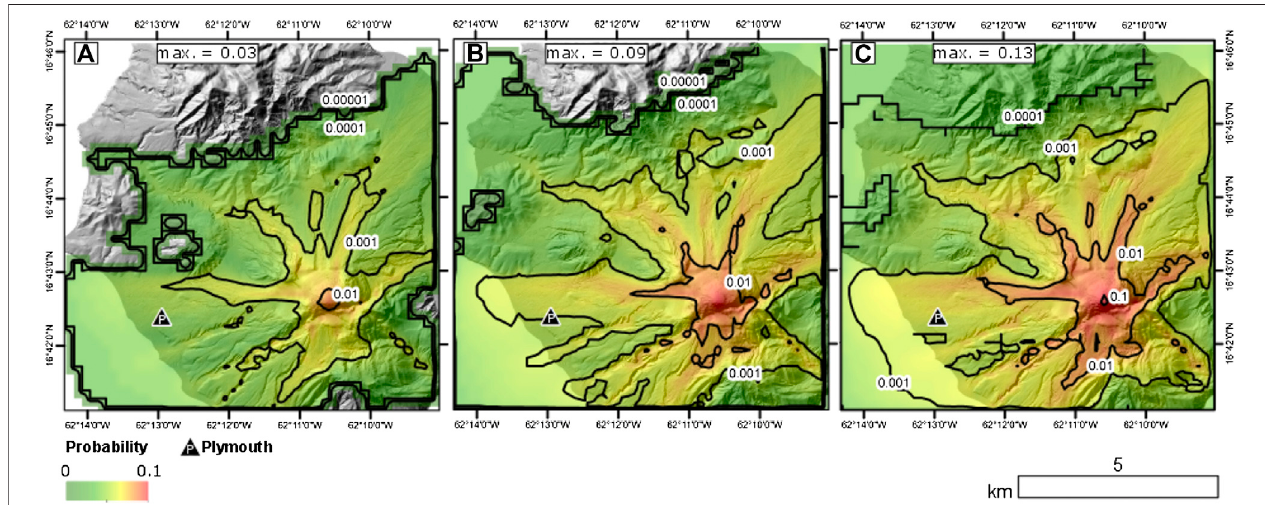
FIGURE 6 | Probability of PDC inundation forecasts plotted on a log 10 color scale, under the assumption of a uniform distribution for p ( ϕ ) over the entire range − 180 + < ϕ ≤ 180 + .Inundationprobabilitycontoursareplottedforvisualreference.Panel (A) isaforecastfor s (cid:2) 1year, (B) for s (cid:2) 5years,and (C) for s (cid:2) 20yearsintothe future. Location of Plymouth is indicated by small triangle due west of